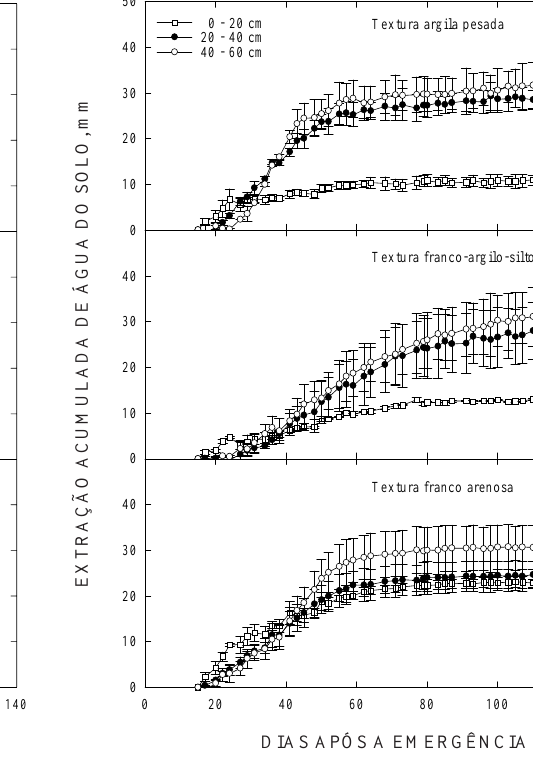
Figura 1. Valores da taxa de extração média diária de água no solo pelas plantas de milho submetidas a déficit hídrico terminal em cada profundidade do solo em três solos de diferentes texturas. As barras verticais representam o desvio-padrão.